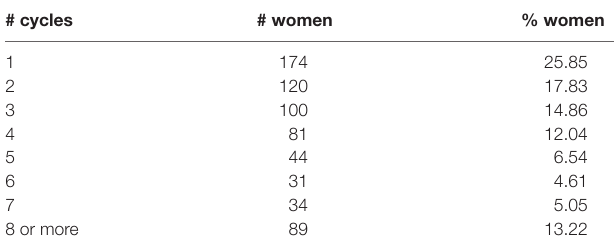
Table 5 | Number and percentage of women by menstrual cycles.